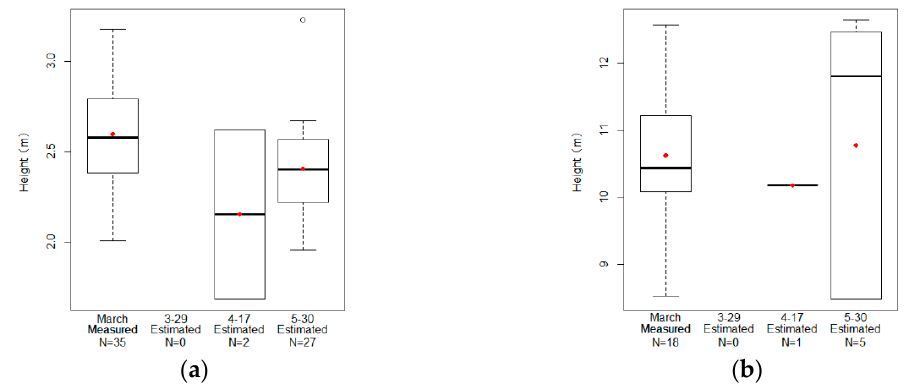
Figure 9. Box-and-whisker plot of the measured height and estimated height on the three dates for deciduous species CS ( a ) and GB ( b ).